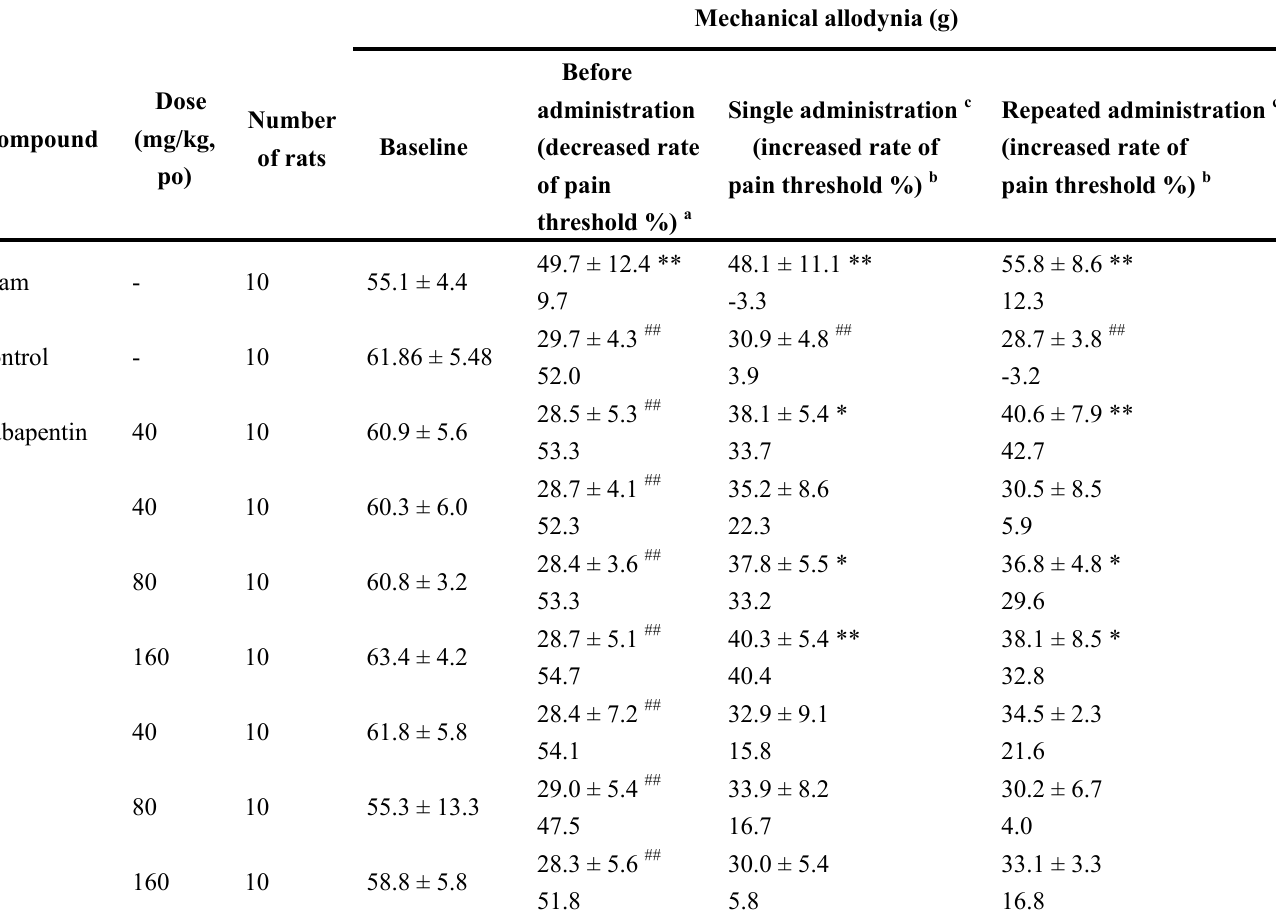
Table 4. Effects of compounds on mechanical allodynia in the SNI model.